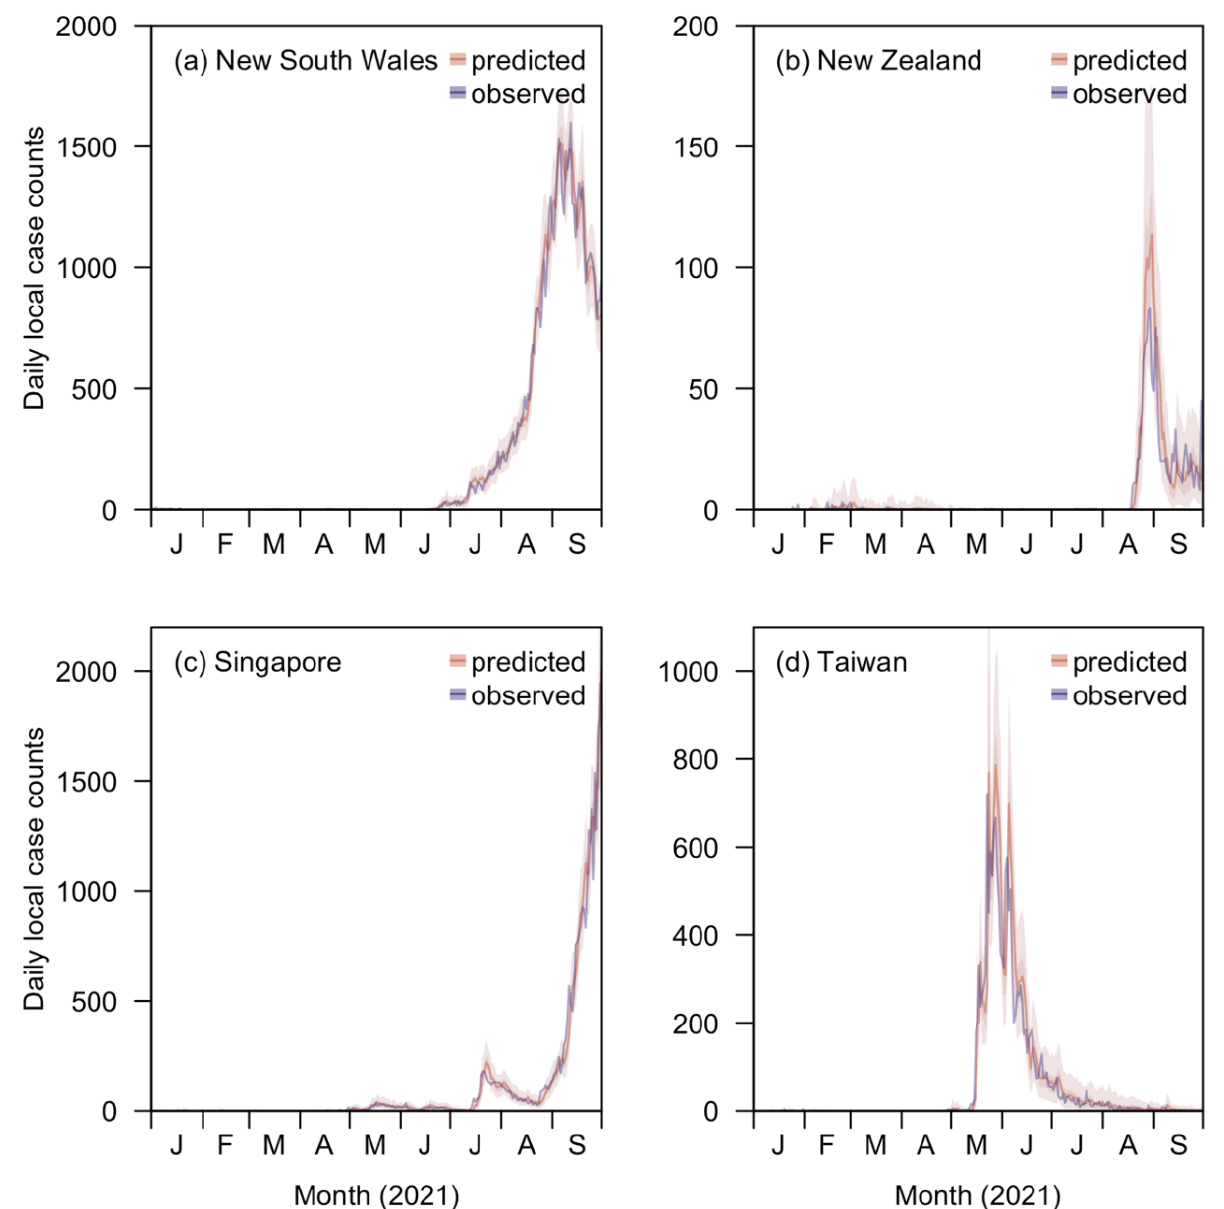
Figure 3. Comparison of the reported local case counts with the case counts forecasted (one day ahead) with the posterior predictive distribution of time-varying effective reproduction number, R t , in: ( a ) New South Wales; ( b ) New Zealand; ( c ) Singapore; ( d ) Taiwan, estimated by EpiRegress using all the covariates available (i.e., the full model).